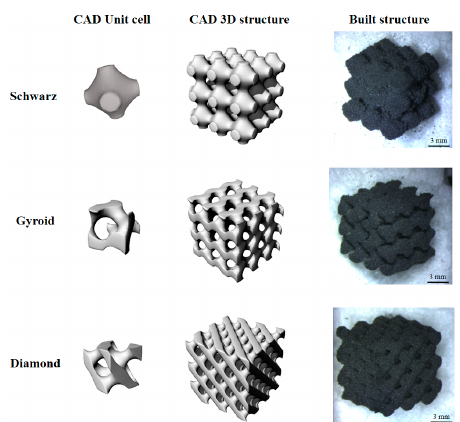
Figure 2. Visualization of the three designed porous structures. CAD-designs of the unit cells (left column); CAD-designs of 3 × 3 × 3 assembled structures (center column); photos of the TPU/GE SLS fabricated structures (right column).